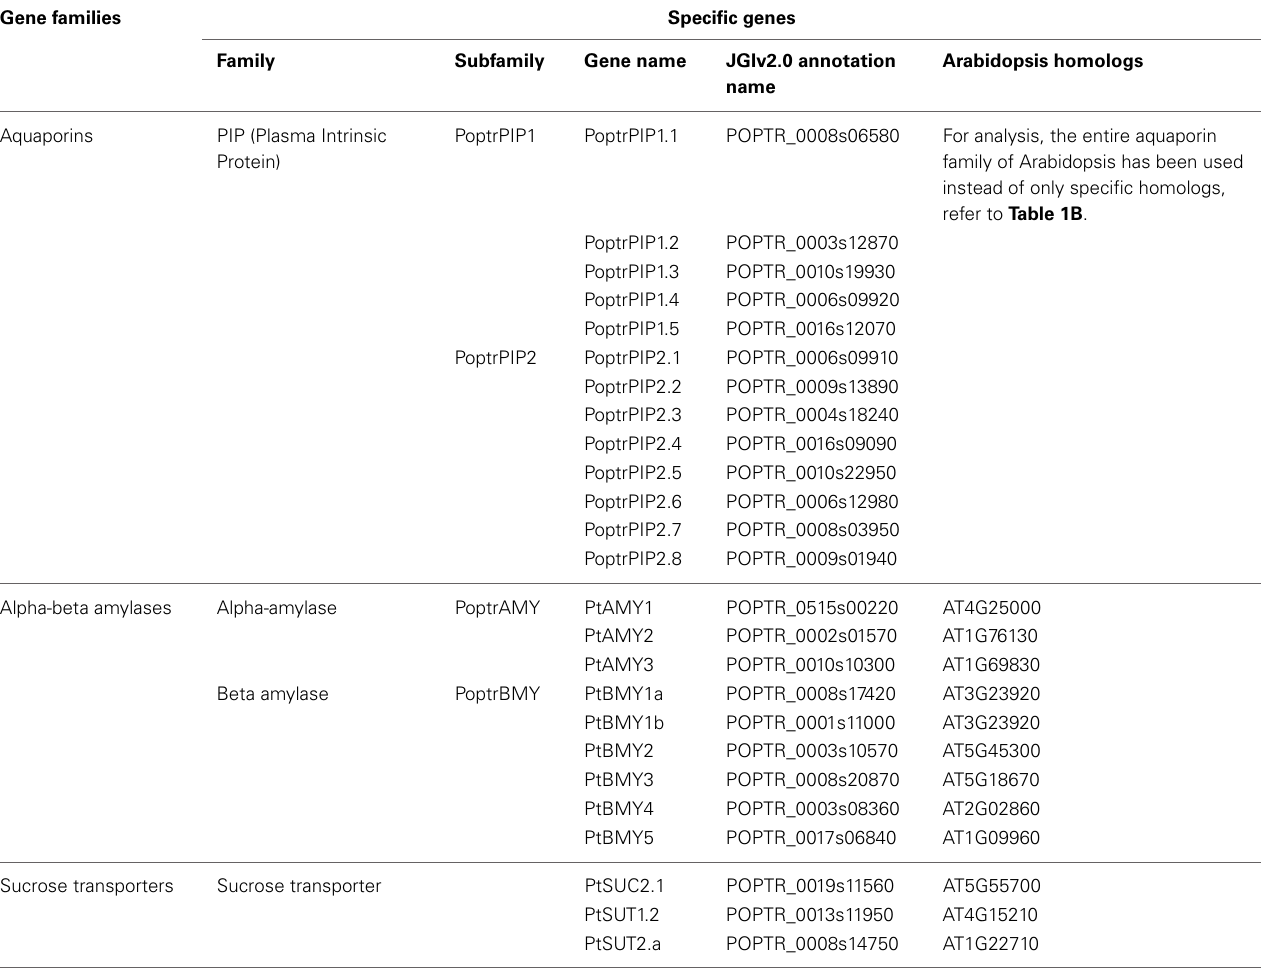
Table 1A | Genes, families and members important in refilling experimentally reported in Populus trichocarpa